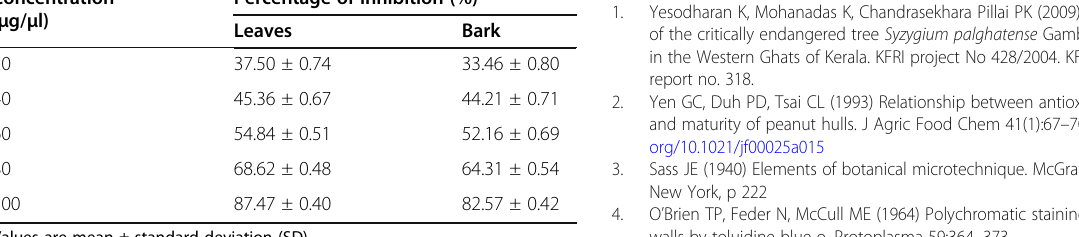
Values are mean ± standard deviation (SD)